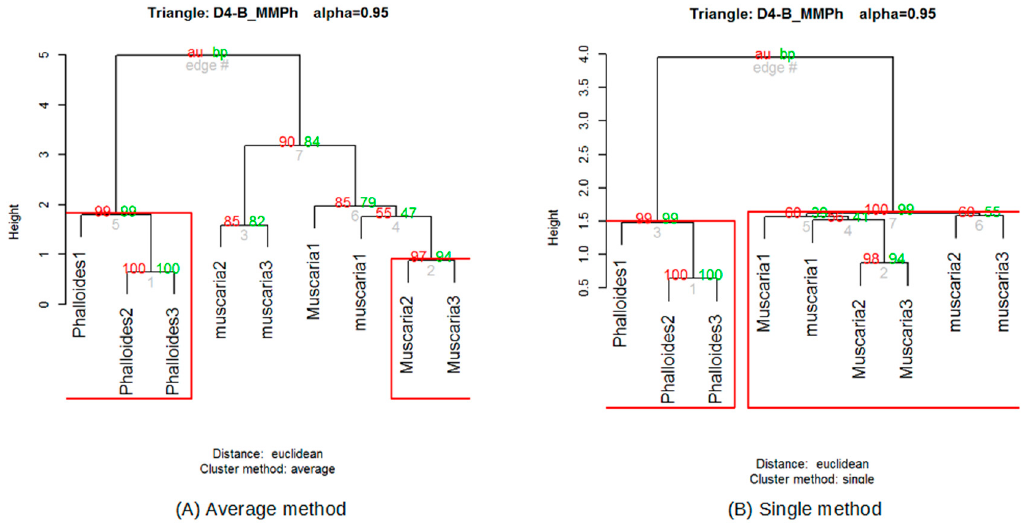
Figure 7. Di ff erences in dendrograms for the same data with average ( A ) and single Figure 7. Differences in dendrograms for the same data with average ( A ) and single ( B ) grouping ( B ) grouping methods.